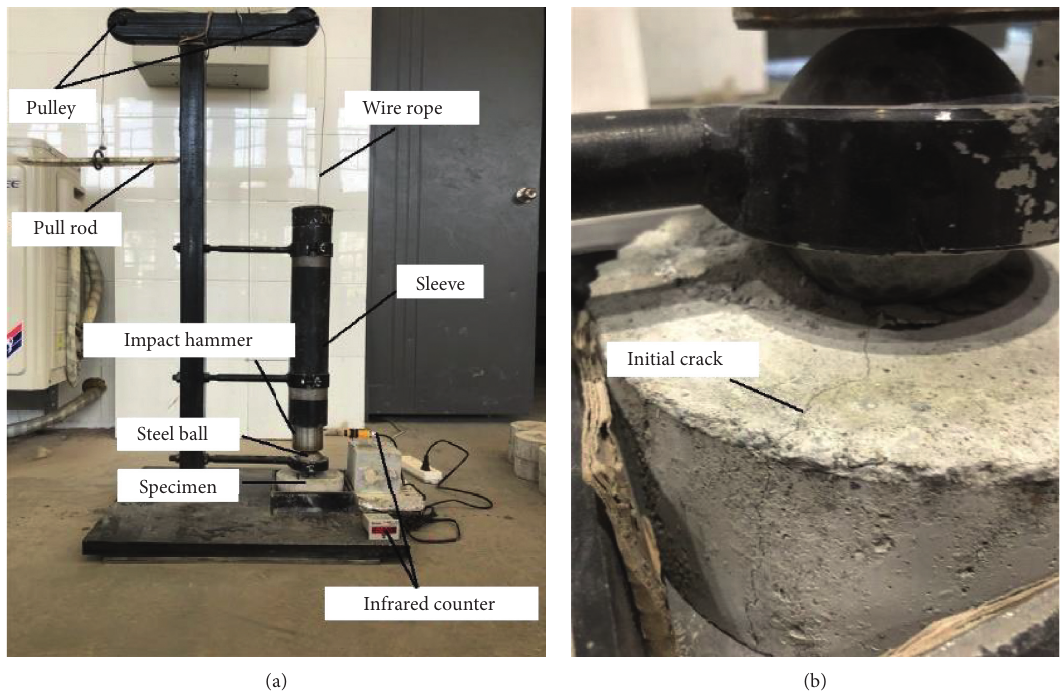
Figure 4: Impact test. (a) Self-made impact test device. (b) Initial